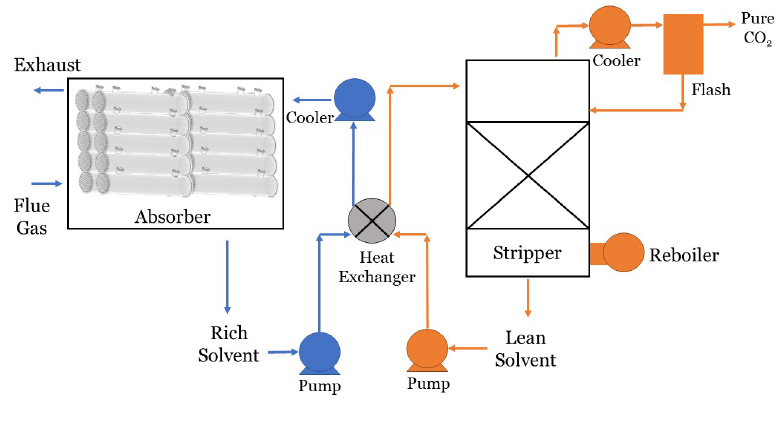
Figure 11. Graphic of a conventional CO 2 capture process using HFMC modules in the absorber. The blue represents the absorption process, and the orange represents the stripped portion of the